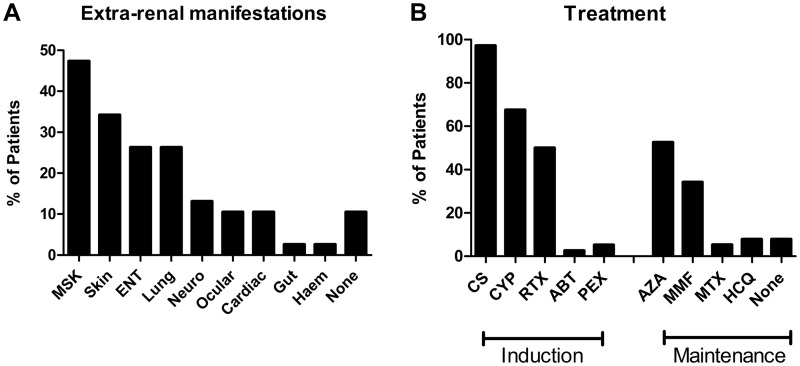
Extrarenal manifestations and immunosuppressive treatments used in this cohort(A) Extra-renal manifestations at the time of renal diagnosis. (B) Agents used for induction and maintenance immunosuppression. ABT: abatacept; Haem: haematological; MSK: musculoskeletal; Neuro: neurological; PEX, plasma exchange; RTX: rituximab.